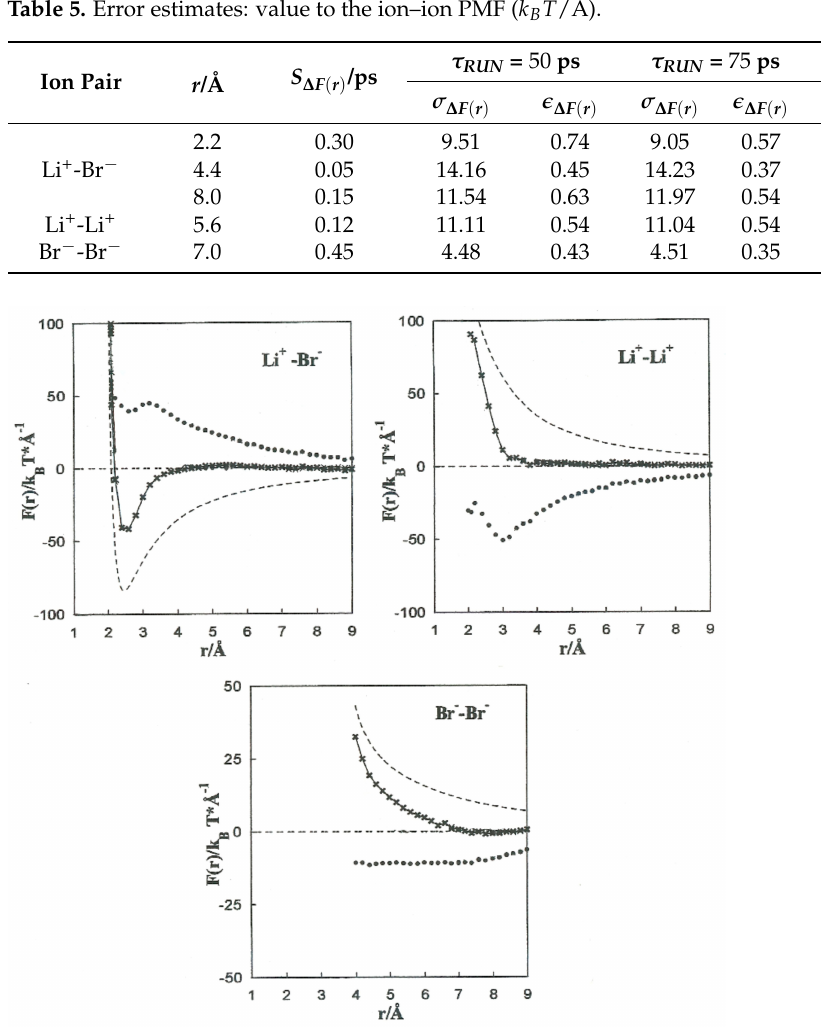
Figure 4. Contributions to the mean force acting on the Li + -Br − , Li + -Li + , and Br − –Br − ion pairs.